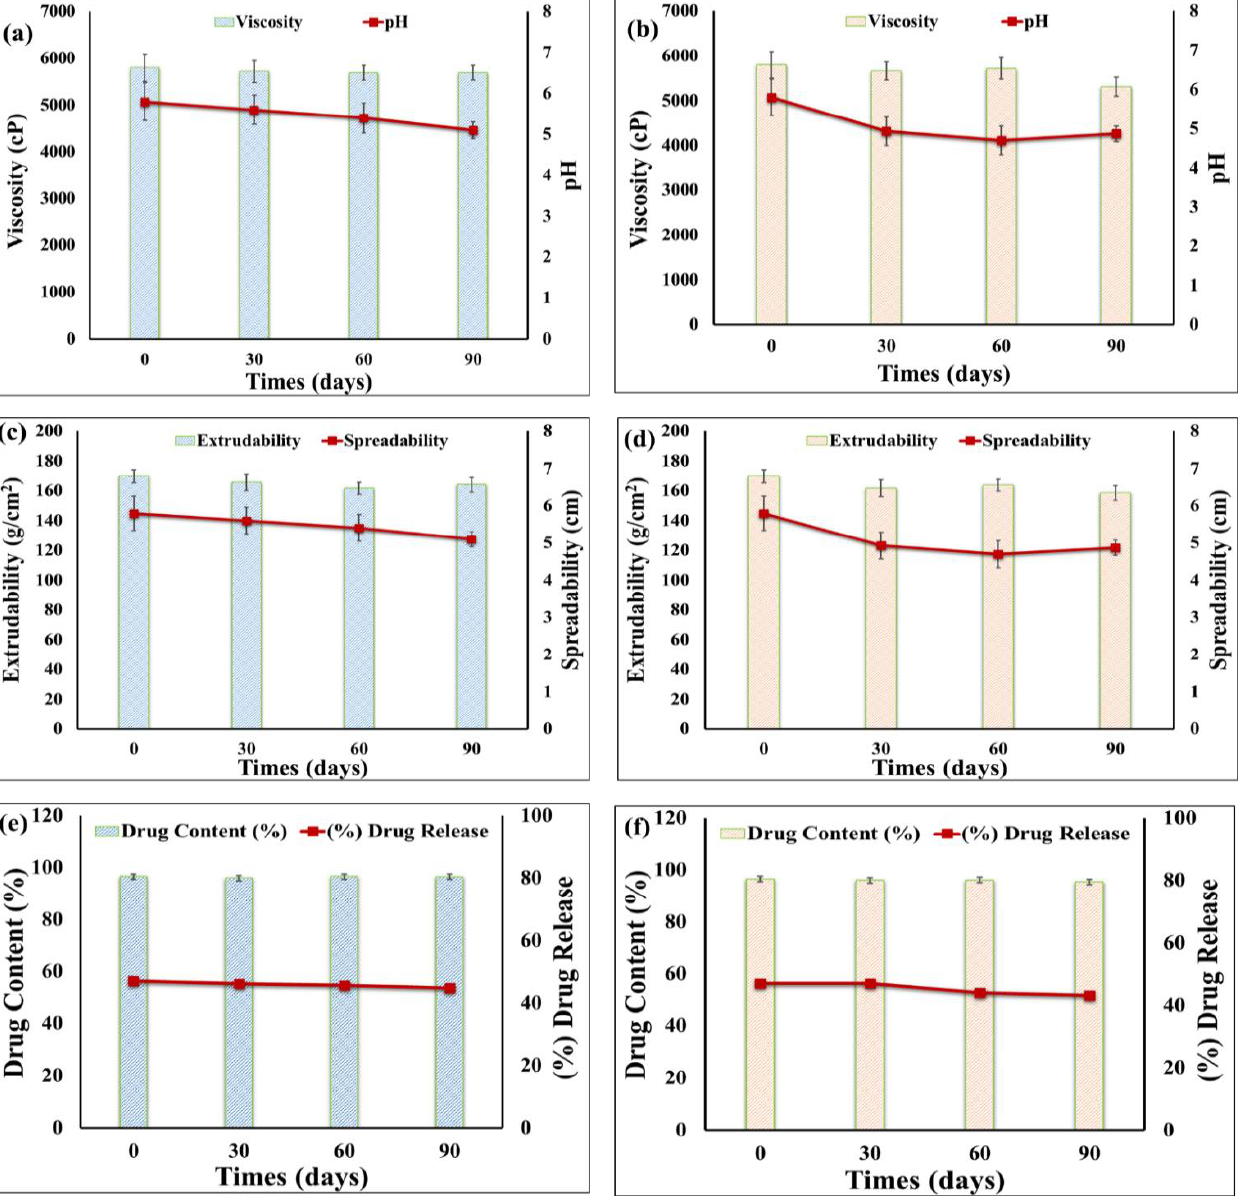
Figure 7. Outline of stability study for erythromycin-loaded cinnamon oil-based transethosomal emulgel in comparison to freshly prepared formulation at 25 °C ( a , c , e ) and 4 °C ( b , d , f ). The effects were determined on pH and viscosity ( a , b ), extrudability and spreadability ( c , d ), percentage of drug content and percentage of drug release ( e , f ).